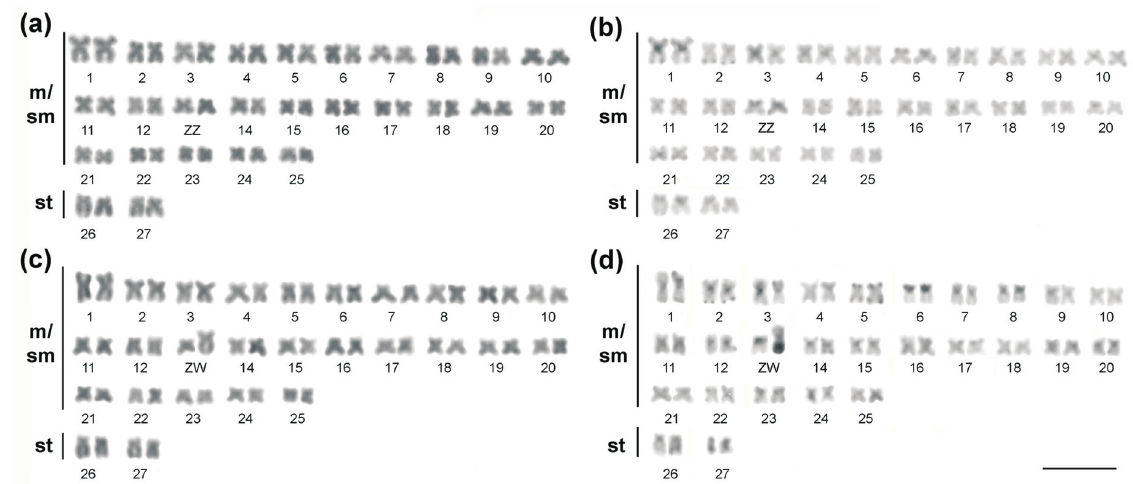
Figure 2 - Karyotypes of the males (a, b) and females (c, d) Apareiodon sp. specimens. Giemsa staining (a, c) and C-banding (b, d). Bar = 10 (cid:2)